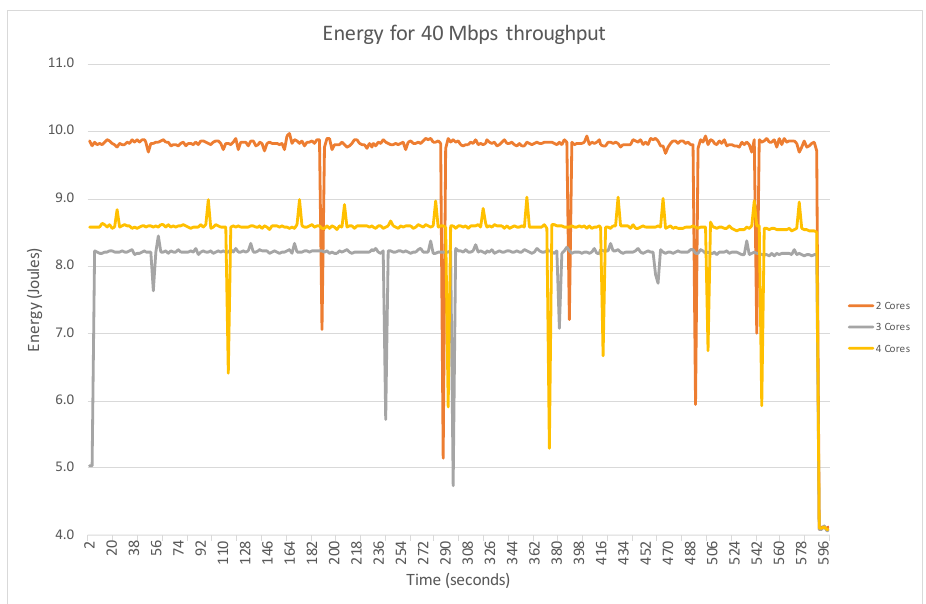
Figure 9. Energy consumed during the last second that proceeds the measurement for different number of cores during a 40 Mbps